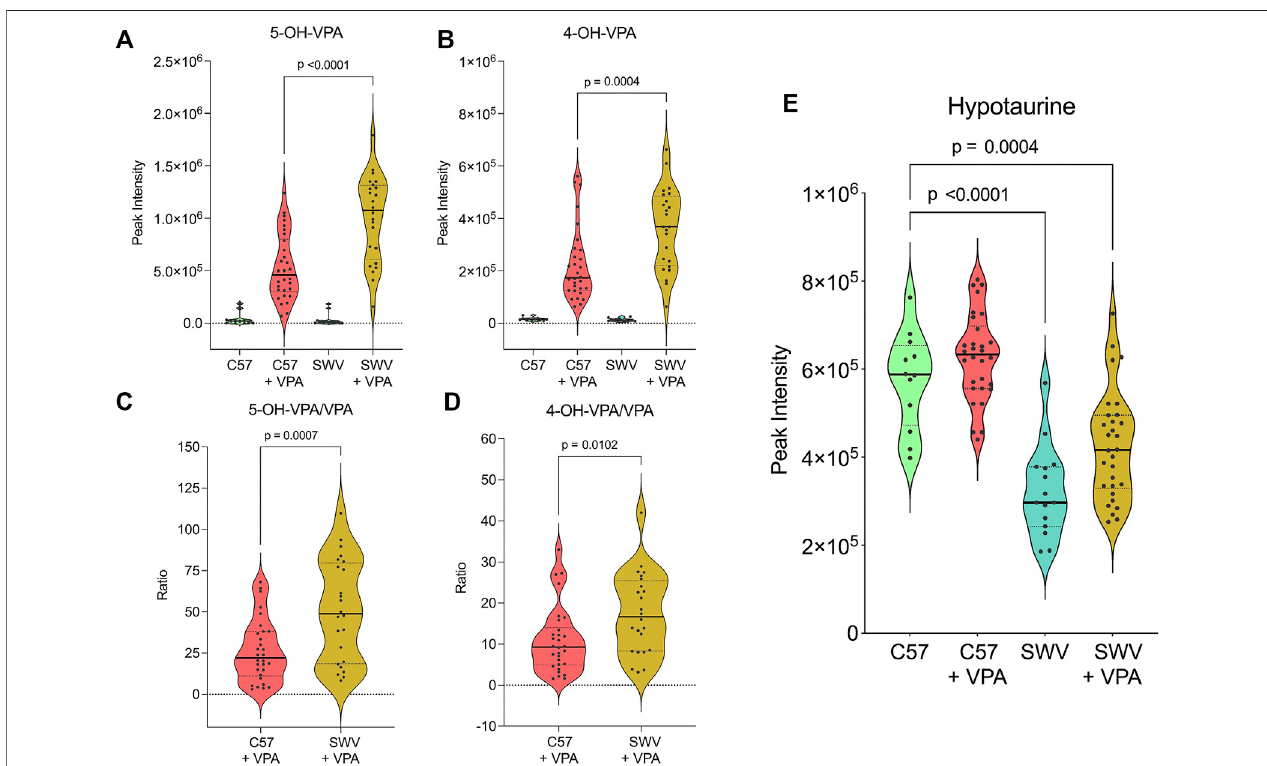
FIGURE3| MetabolitesofinterestdistinguishingSWVandC57embryos.Metabolitepeakintensitiesfor (A) 5-OH-VPAand (B) 4-OH-VPA. (C) Ratioof5-OH-VPA to unmetabolized VPA in VPA-treated embryos. (D) Ratio of 4-OH-VPA to unmetabolized VPA in VPA-treated embryos. (E) Metabolite peak intensities for hypotaurine. *Statistical signi fi cance determined by Student ’ s t-test (C,D) and one-way ANOVA with Tukey ’ s multiple comparisons (A,B,E) ( α < .05).